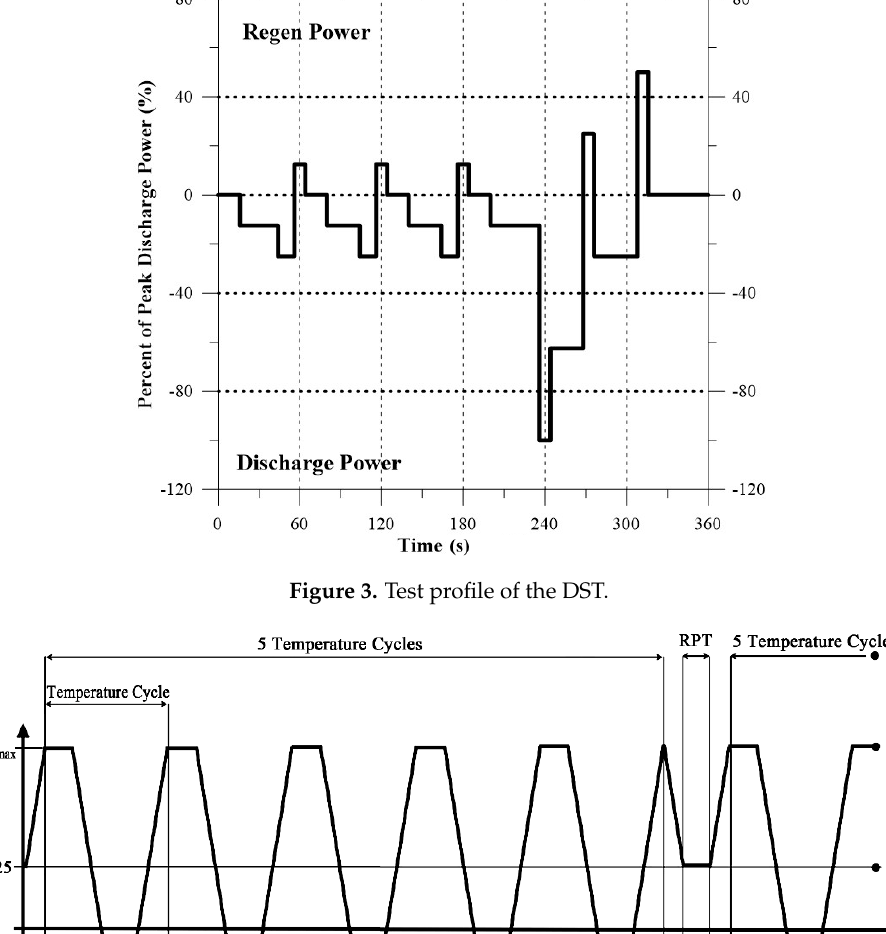
Figure 3. Test profile of the DST. Table 3. Test procedure of the DST.